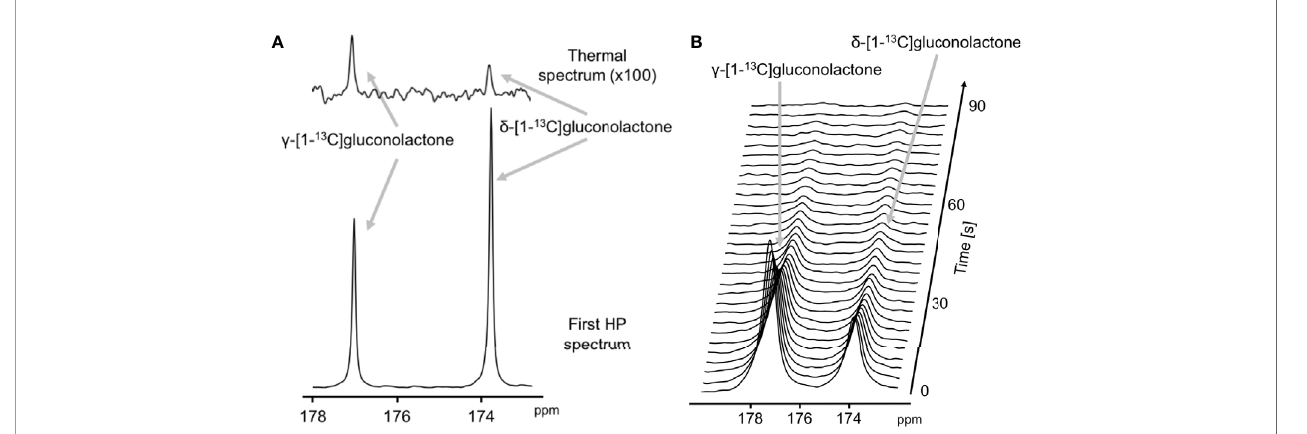
FIGURE 3 | Characterization of hyperpolarized d -[1- 13 C]gluconolactone. (A) Representative thermal equilibrium (top) and hyperpolarized 13 C MR spectrum (bottom) of d -[1- 13 C]gluconolactone. (B) Representative stack plot of 13 C MR spectra of hyperpolarized d -[1- 13 C]gluconolactone in solution (temporal resolution 3